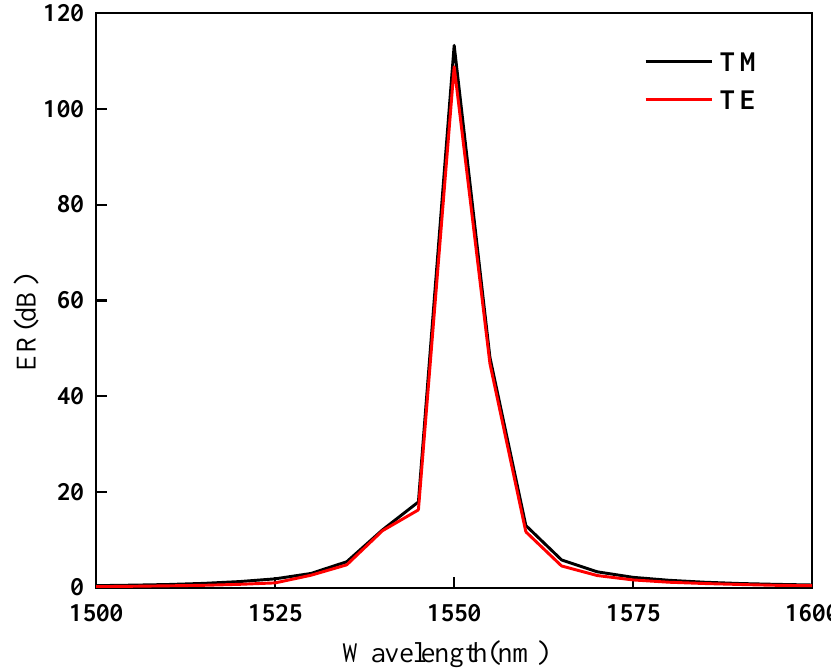
  0.61 eV is selected as “ON” state and Figure 7. When c change of the ER with wavelength for both TM and TE modes is